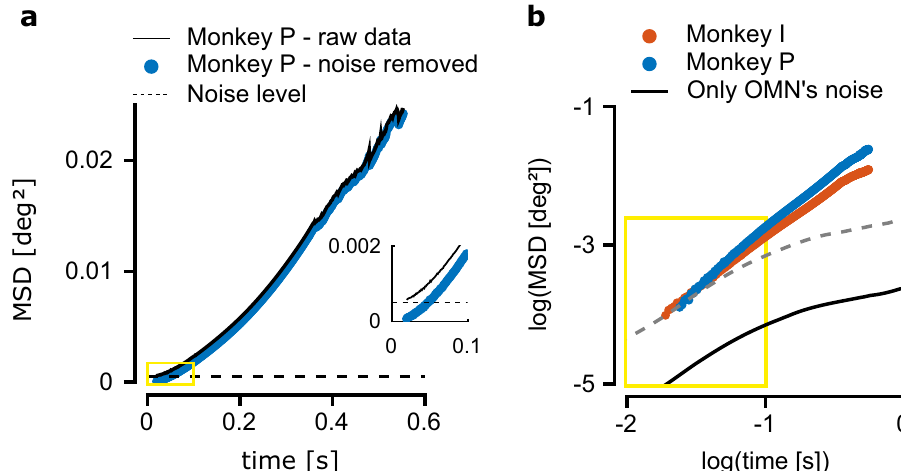
Fig. 3 Motoneuron variability can ’ t explain the mean squared displacement at large time lags. a Mean squared displacement (MSD) curve, measured for monkey P with measurement noise (black trace). Dashed horizontal line: estimate of the contribution arising from measurement noise (Methods). Blue circles: MSD after subtraction of the measurement noise contribution. Inset: zoom in over the area marked by the yellow rectangle. Note that the black trace doesn't approach zero at zero time lag, which is indicative of contamination by temporally uncorrelated measurement errors. b Mean squared displacement (MSD) curves from both monkeys (blue and red traces), using logarithmic scales in both axes, after subtraction of the measurement noise contribution. Black trace: MSD obtained by simulation of the contribution arising from the spiking variability of OMNs, fi ltered by the response dynamics of the muscles and mechanics of the eye (assuming 2000 heterogeneous OMNs, see Methods). The black trace fl attens at time lags exceeding ∼ 1 s and can only account for ∼ 1% of the total variance at a time lag of ∼ 900ms. Dashed gray trace: translated copy of the black trace along the logarithmic vertical axis demonstrates that the slope of the MSD curve generated by the OMN variability cannot match the slope of the measured MSD curve. The yellow marked rectangle represents the same range of time lags and MSDs as the yellow rectangle in ( a ), on the logarithmic